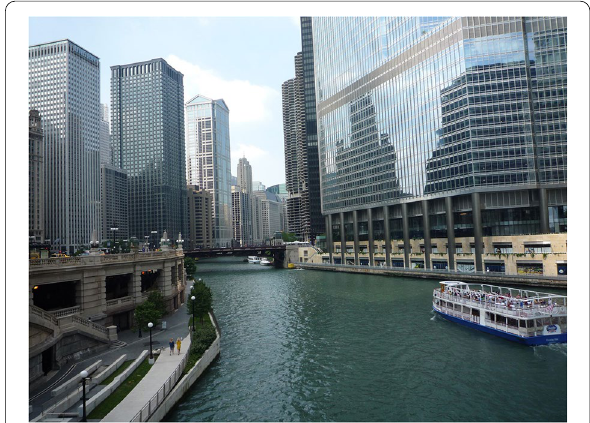
Fig. 2 The Chicago River surrounded by skyscrapers